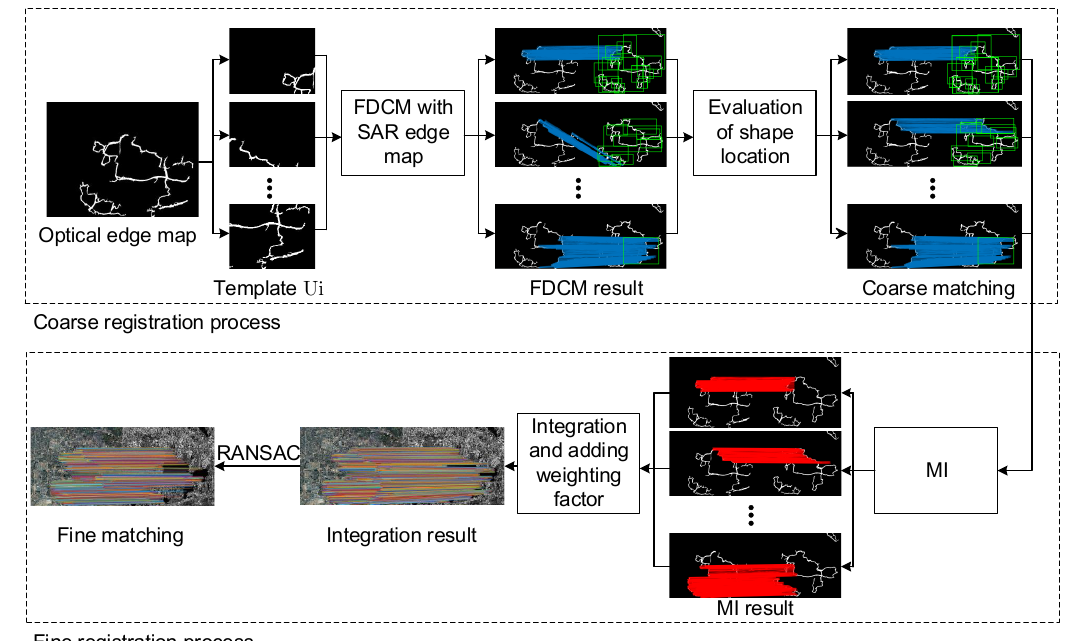
Figure 3. Framework of the mesh grid